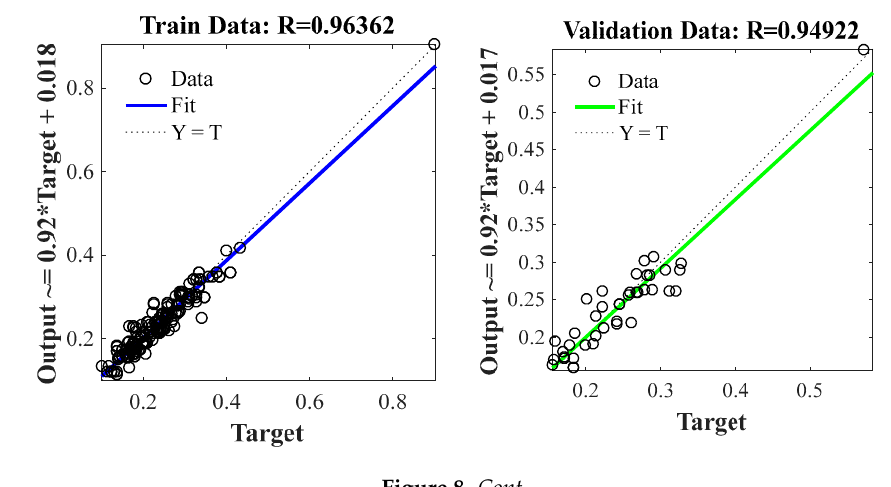
Figure 7. Training state of ANN 6:15:1.